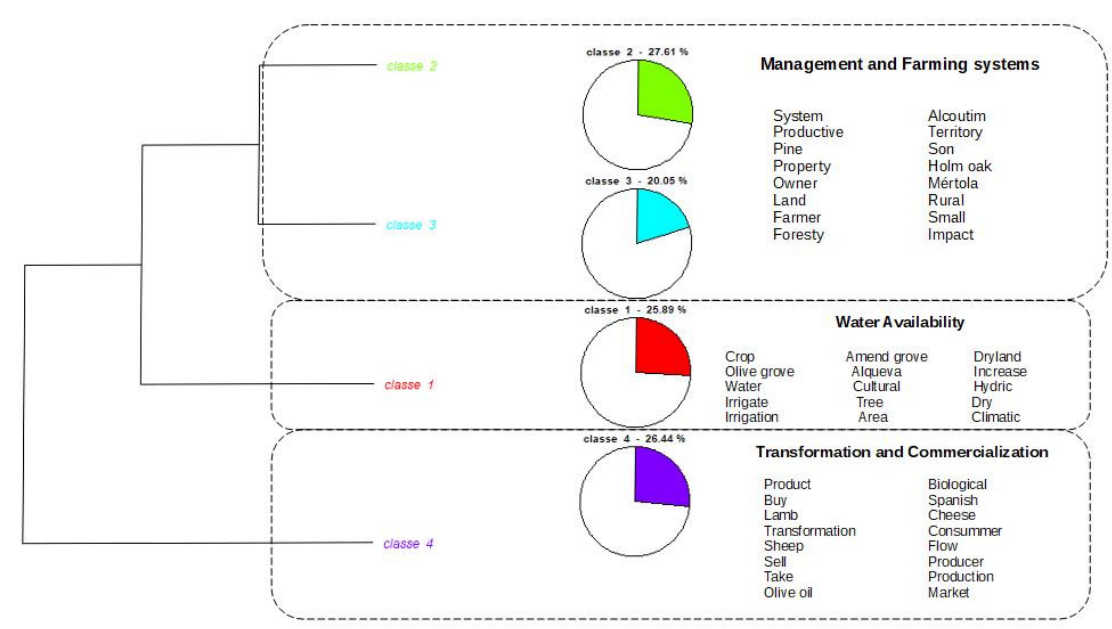
Figure 4. Classes were obtained with the hierarchical classification method ALCESTE. Classes 2 and 3 were grouped and named “management and farming systems”, class 1 “water availability”, and class 4 “transformation and commercialization”. Source: research data analysed by IRAMUTEQ.